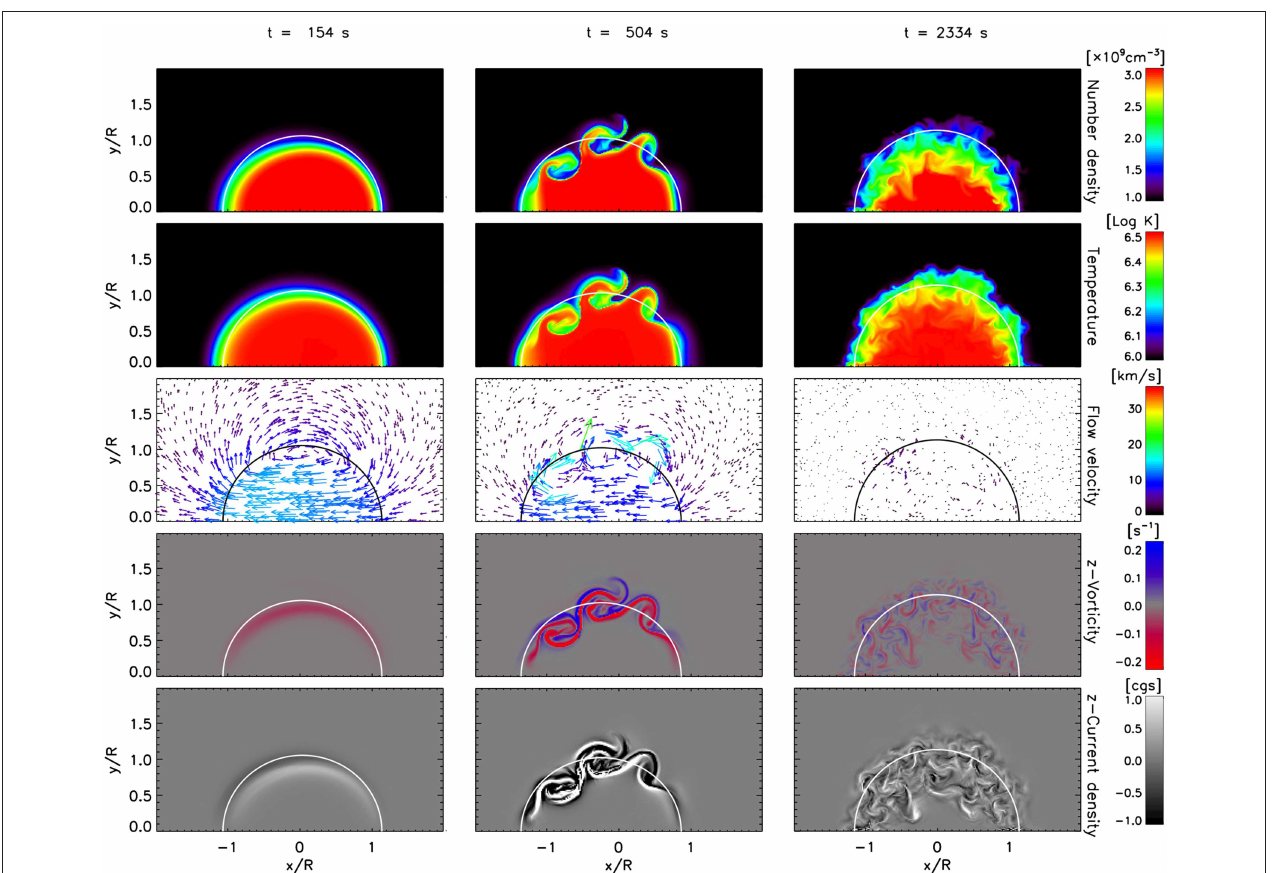
FIGURE 2 | TWIKH vortices throughout for a loop with initial boundary layer and no viscosity. The same variables as in Figure 1 are shown, setting the same minima and maxima for better visualization. The same times are shown, except for the middle panel, for which we select a later time of t the first formation of KHI vortices. See also the accompanying movie in the Supplementary Material